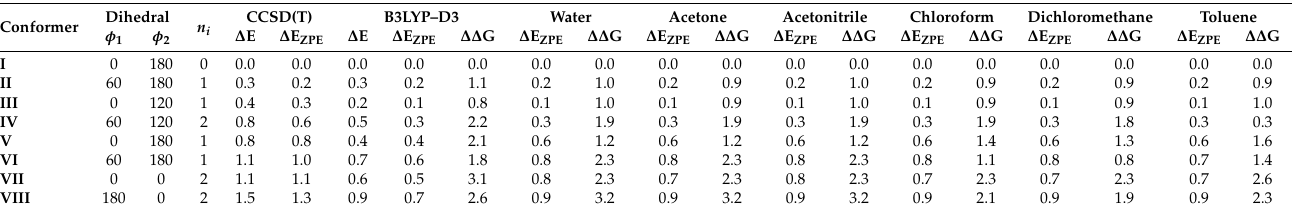
Table 1. Gas phase and solution energy differences in kcal/mol with respect to I , the lowest energy structure, for all caffeine conformers shown in Figure 2. ∆ E: purely electronic energies. ∆ E ZPE : electronic energies corrected by the B3LYP–D3 ZPE. ∆∆ G: relative Gibbs energies at room conditions. Basis set: 6–311++G( d , p ). n i : number of imaginary frequencies. CCSD(T) energies calculated